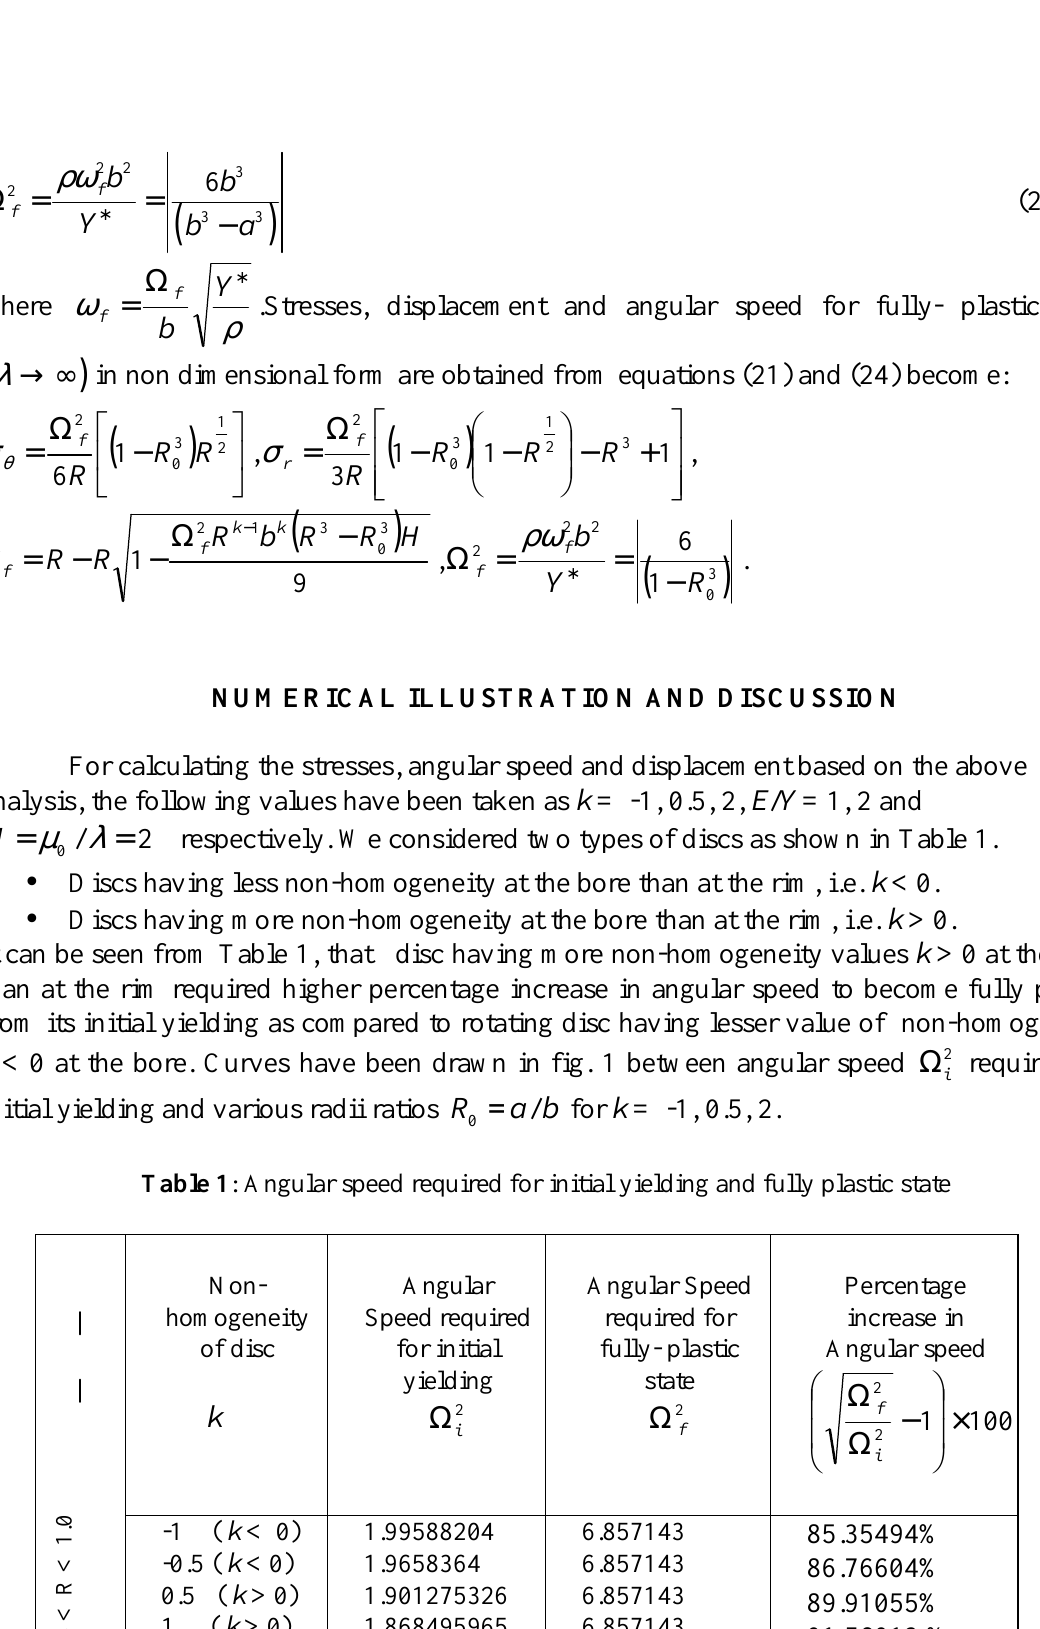
Angular Speed required for initial yielding